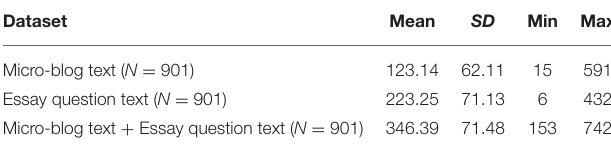
TABLE 1 | The basic statistics of text length in three text datasets.